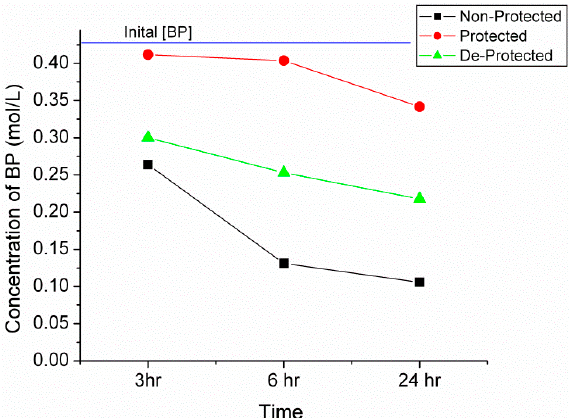
Figure 2. Plot of benzophenone (BP) concentration determined via gas chromatography (GC) for the non-protected, protected and de-protected propylamine reactions at 3, 6 and 24 h.